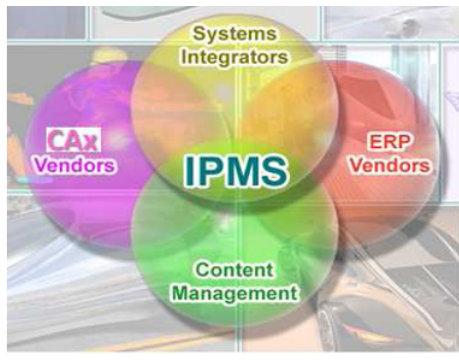
Figure 5. Integrated Product Management Systems